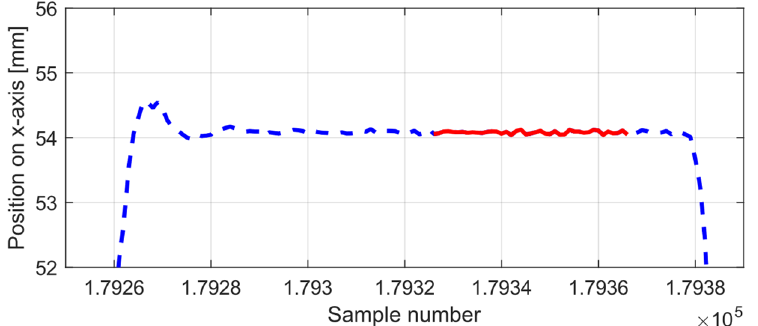
Figure 15. Example of selecting the x -axis stop data (solid red line) from the raw robot motion data (dashed blue line).